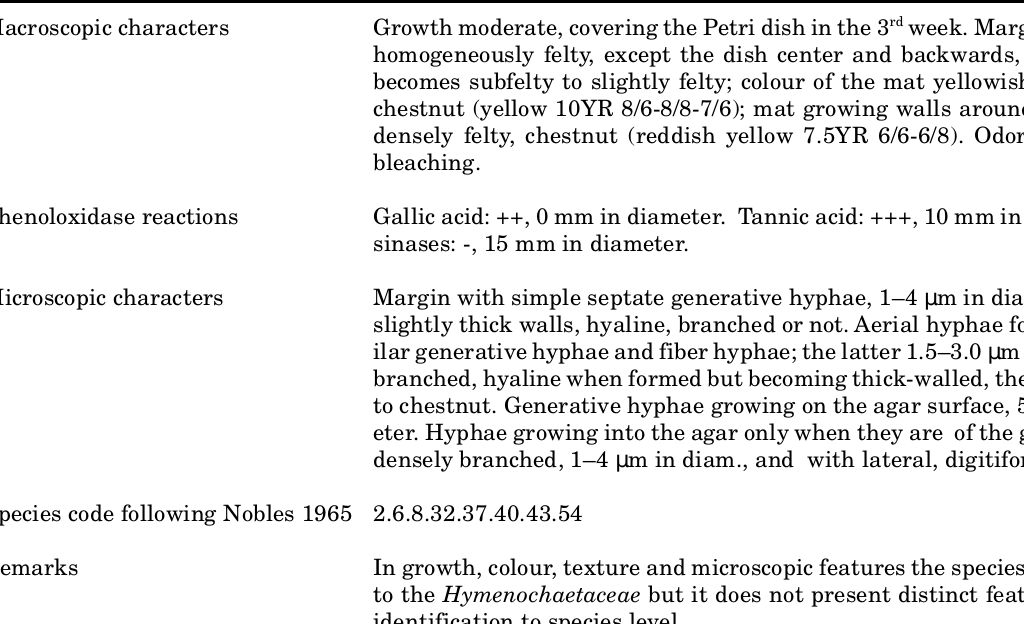
Table 5. Description of the culture of the basidiomycete species isolated from hoja de malvón diseased vines in 1998. Macroscopic characters Growth moderate, covering the Petri dish in the 3 rd week. Margin regular; mat homogeneously felty, except the dish center and backwards, where the mat becomes subfelty to slightly felty; colour of the mat yellowish, beige to light chestnut (yellow 10YR 8/6-8/8-7/6); mat growing walls around the inoculum, densely felty, chestnut (reddish yellow 7.5YR 6/6-6/8). Odor none. Reverse bleaching. Phenoloxidase